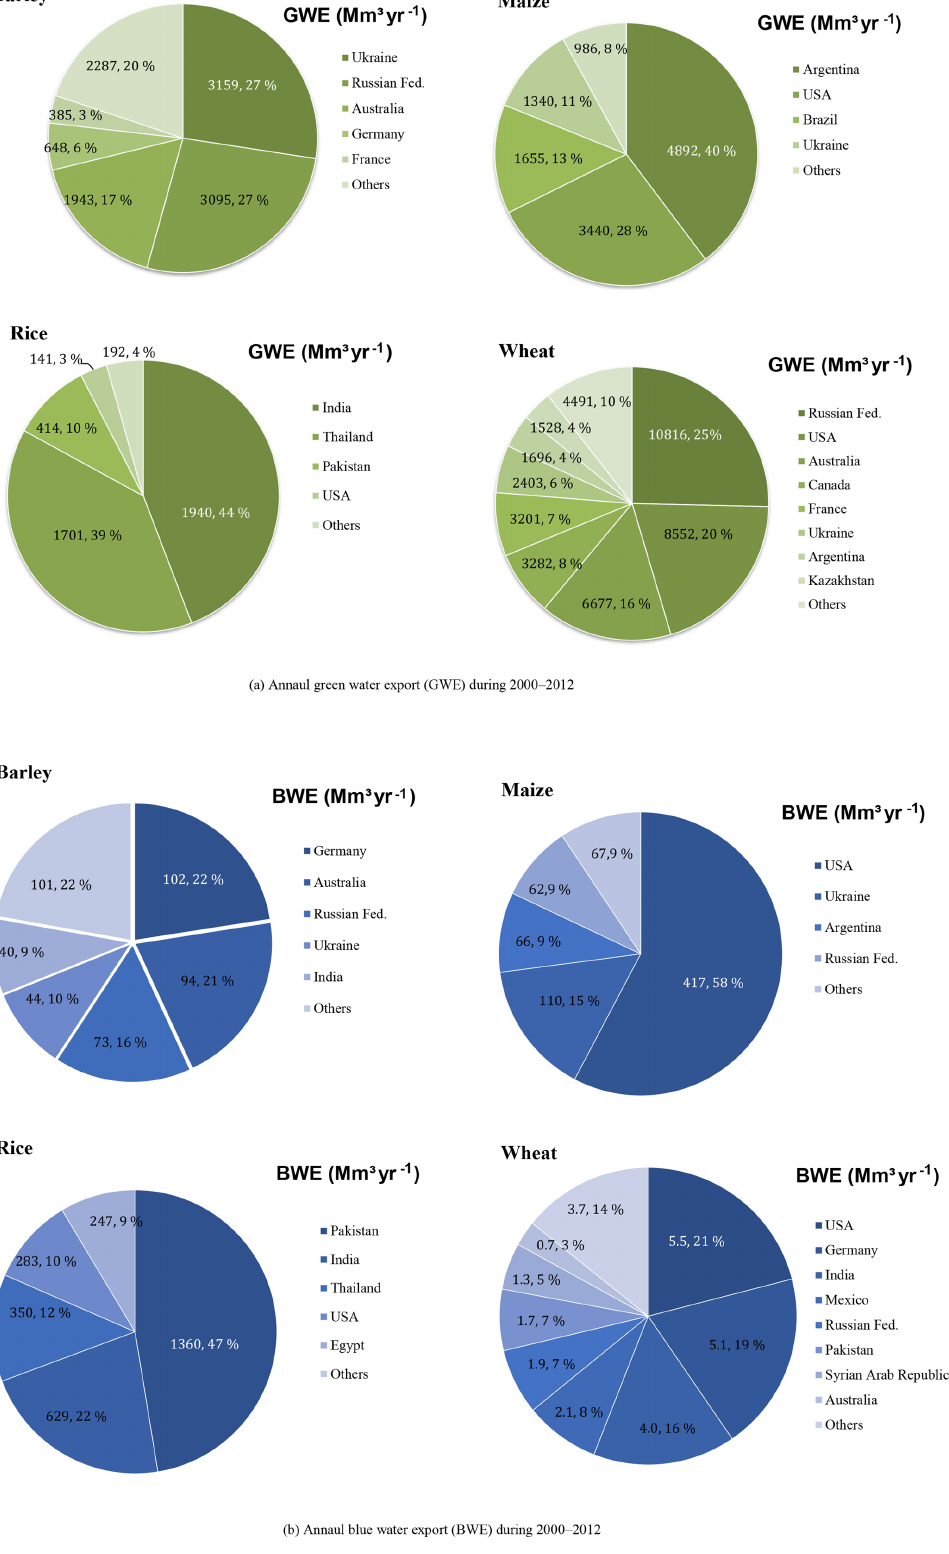
Figure 3. Quantities of green water export (GWE) and blue water export (BWE) from the primary exporters to the MENA region from 2000 to